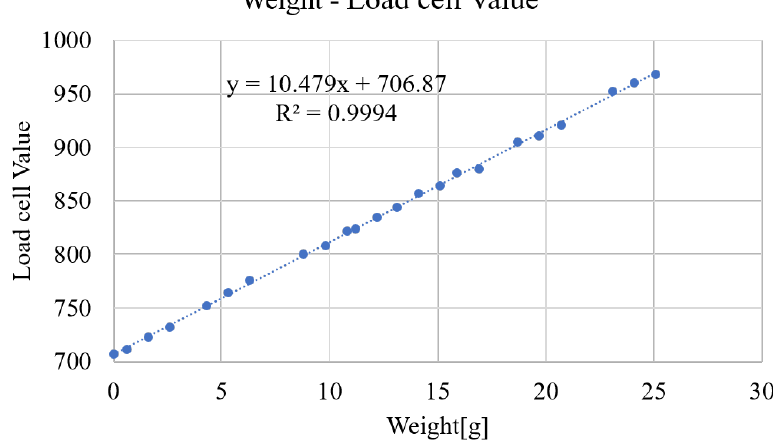
Figure 3. Load cell calibration. We measured load cell value by applying offset pressure by the magnetic force and arbitrary weight.